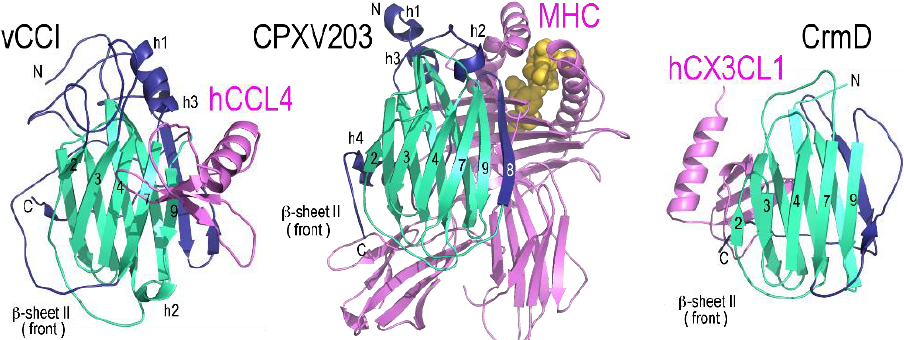
Figure 5. PIE domain proteins use unique determinants to engage ligands. vCCI primarily employs sheet II to bind CC-chemokines (2FFK) [20], CPV203 (T4) uses the edge of the β -sandwich plus part of sheet I to bind MHC class I/peptide complexes (4HKJ) [28], and CrmD appears to use sheet I for the binding of a